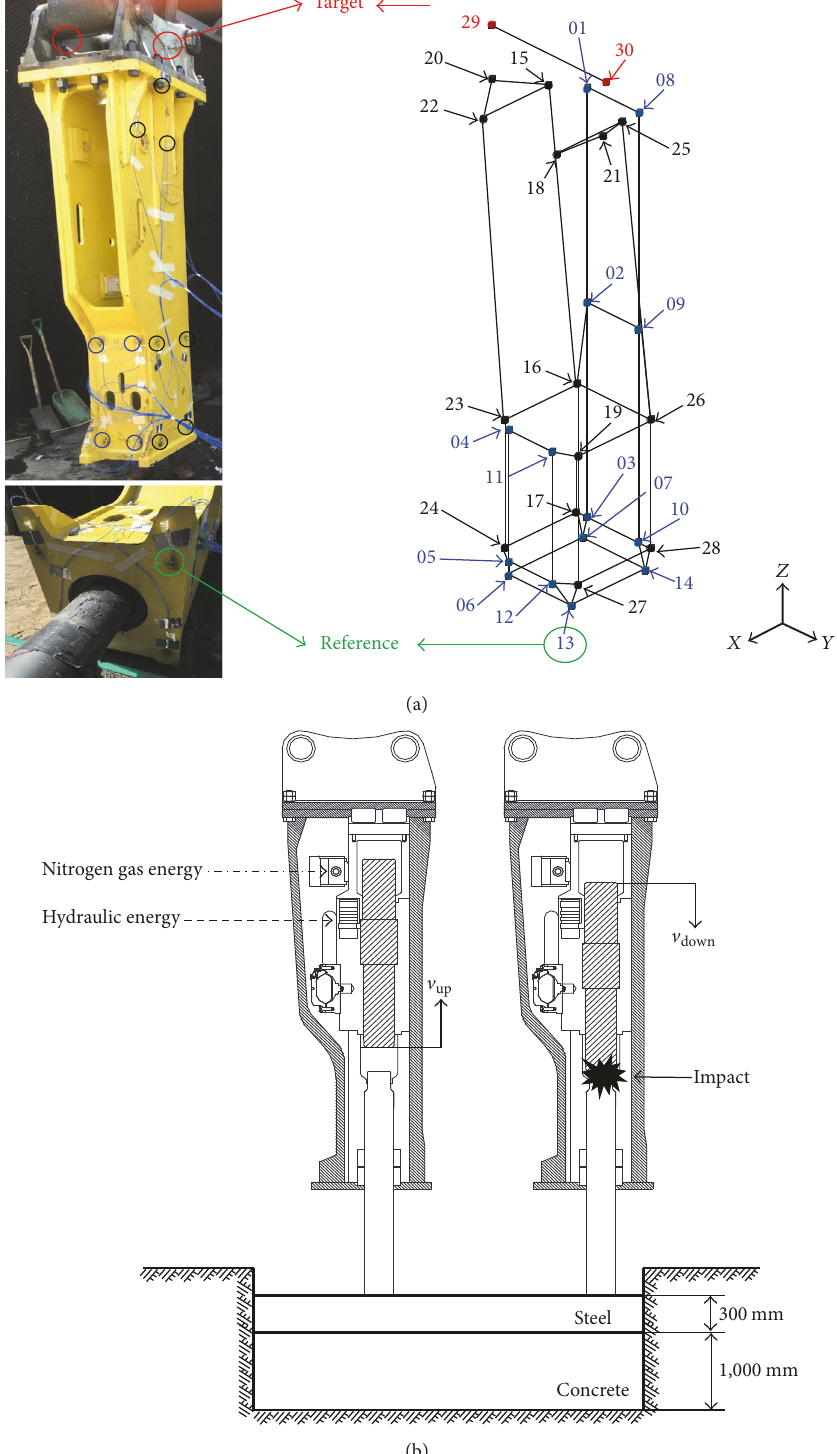
Figure 6: Vibration experiment setup: (a) installation positions of triaxial accelerometers, (b) mechanism of the hydraulic breaker and vibration test